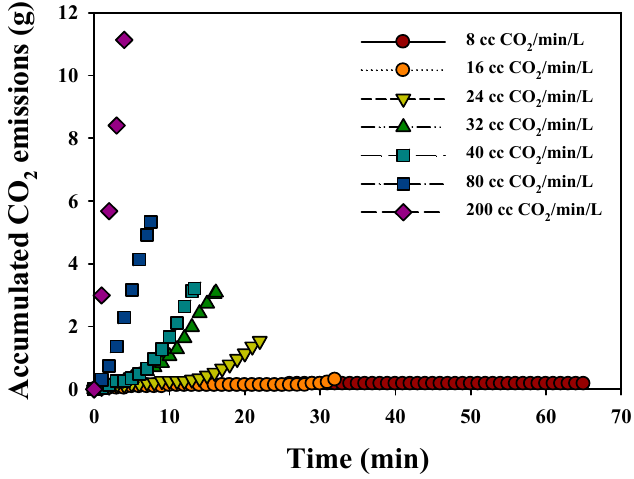
Figure 6. Accumulated CO 2 venting to the atmosphere during carbon mineralization processes.